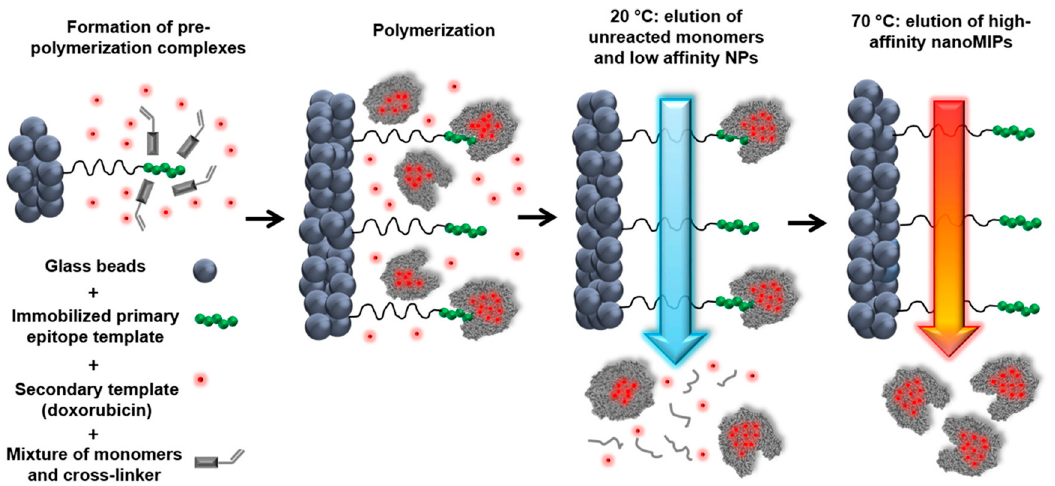
Figure 10. Scheme of the solid-phase synthesis process for double-imprinted nanoMIPs using a peptide epitope of EGFR as primary template attached to the solid phase and doxorubicin as secondary template in solution. Adapted with permission from Canfarotta et al. [140].